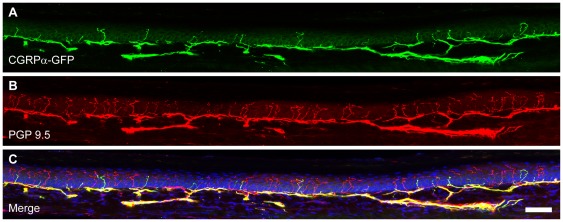
Glabrous skin montage. Sections from the glabrous skin of the hindpaw from CGRPα-GFP+/? mice were stained with antibodies to (A) GFP and (B) PGP9.5. (C) Merged images were stained with the nuclear marker DRAQ5. Images were acquired by confocal microscopy and are representative of n = 3 mice. Scale bar in (C) is 50 μm.